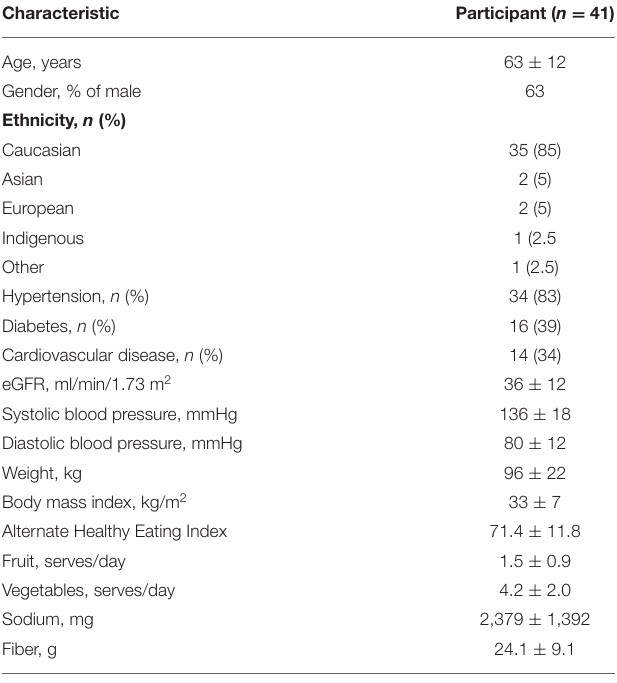
TABLE 2 | Baseline